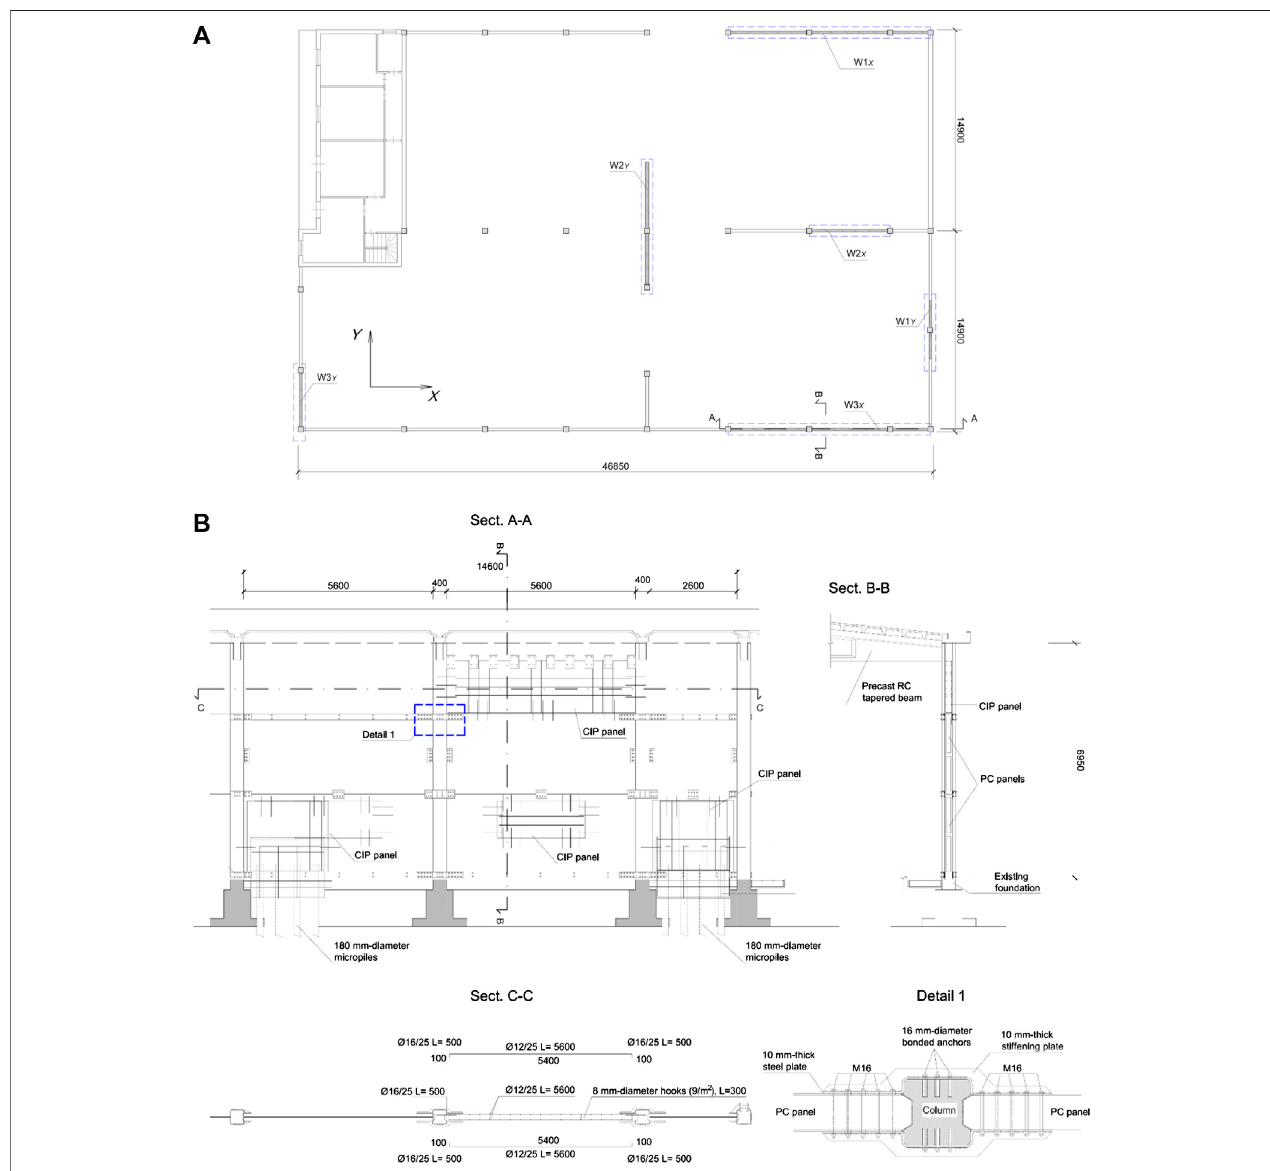
FIGURE6| RCcladdingpanelsreadapted asshearwalls: (A) planviewofabuildingwherethreeshearwallswereobtainedinboth X and Y direction; (B) detailsfor shear wall W 3 X . Dimensions in mm.